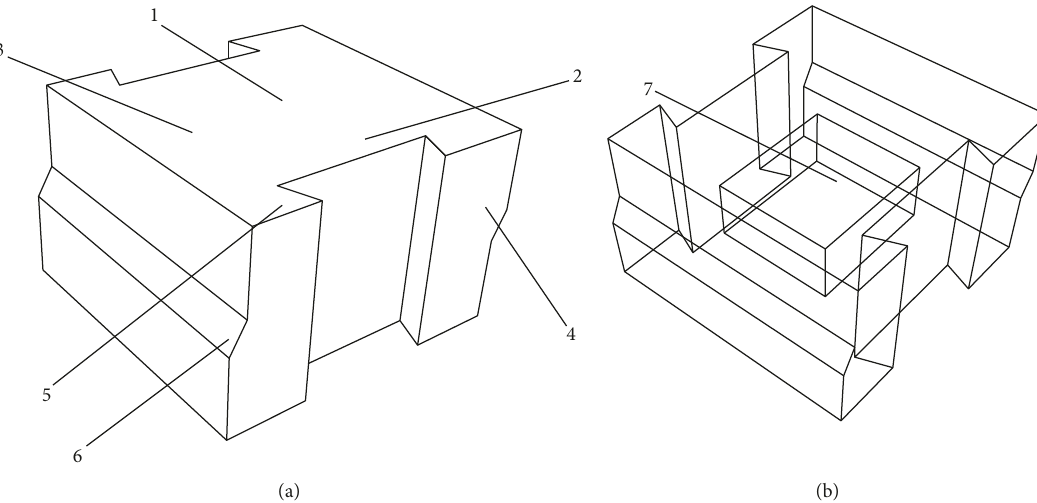
Figure 6: Schematic diagram of block structure. (a) Appearance. (b) Perspective. (1) Abdominal structure; (2) flange structure; (3) flange structure; (4) flange I bending hooks; (5) flange II bending hooks; (6) side concave-convex structure; (7) steel slag core.